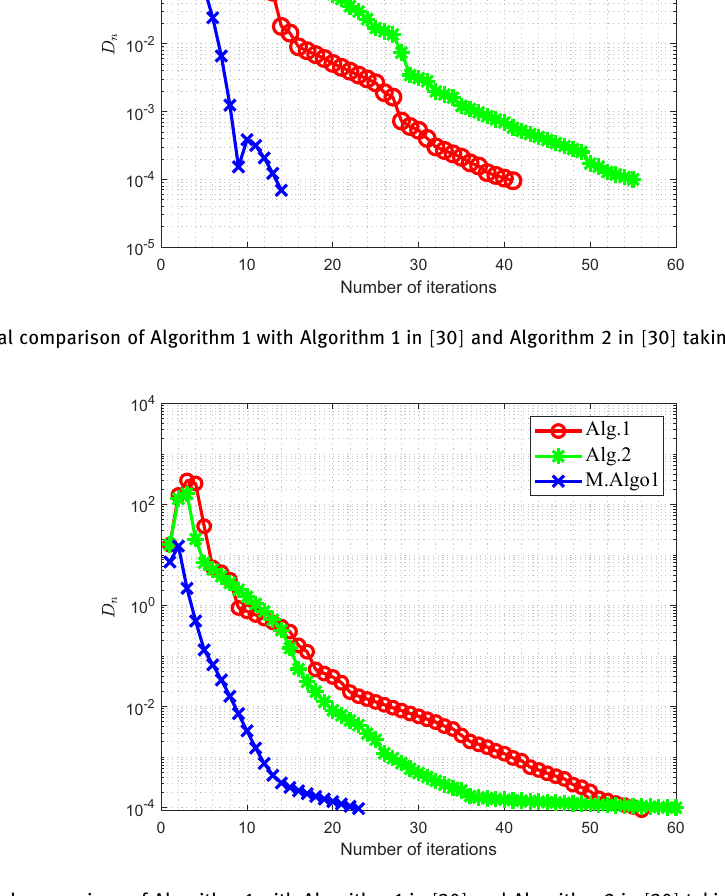
Figure 2: Numerical comparison of Algorithm 1 with Algorithm 1 in [ 30 ] and Algorithm 2 in [ 30 ] taking = N 10 .